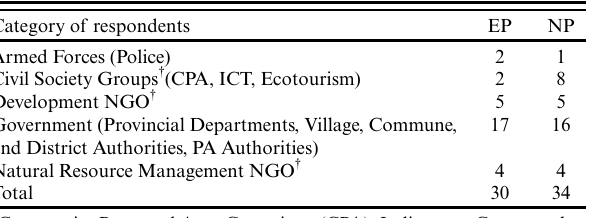
Table 1. Categories of actors interviewed; actors are categorized by